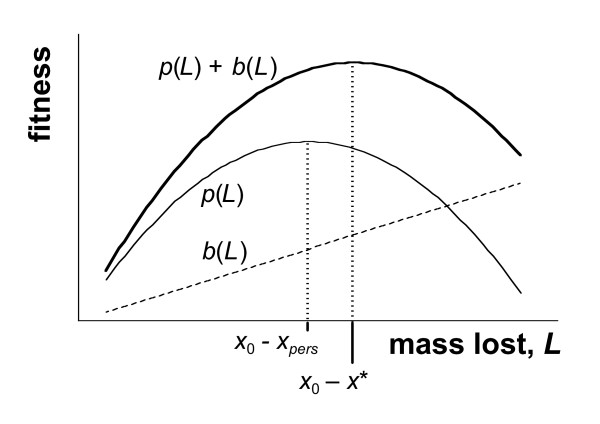
Graph showing the optimal amounts of mass tolose. This sketch (not to scale) demonstrates that the degree of mass lost to reach the optimal mass x* is greater than the loss necessary to reach the optimal parental mass xpers. Note that the shapes of the current fitness component, b(L), and the future fitness component, p(L), are arbitrarily drawn as a linear and a quadratic function here.